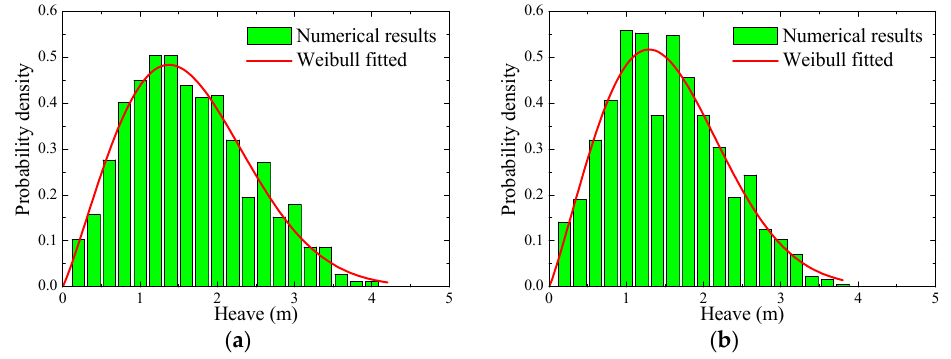
Figure 15. The histogram of heave peak distribution. ( a ) Nonlinear heave crest; ( b ) nonlinear heave trough.